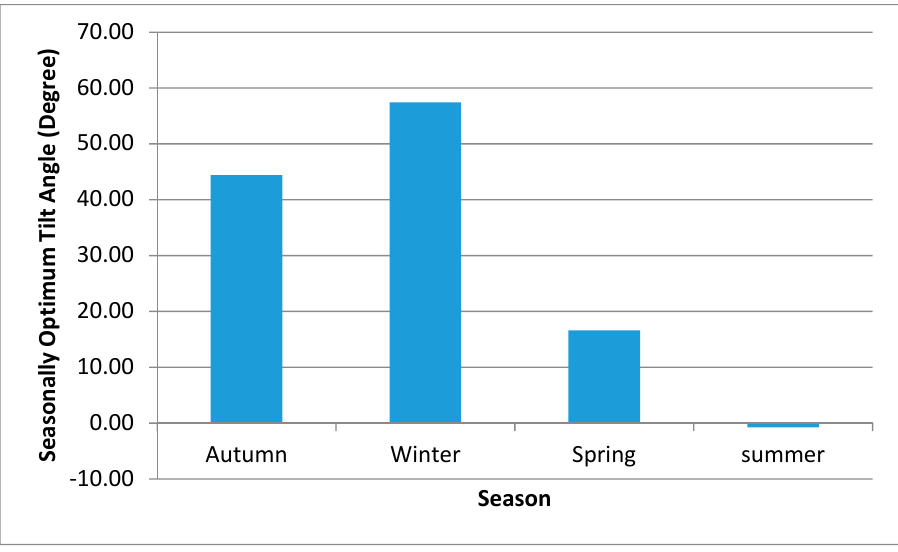
Figure 8. The seasonally optimum tilt angle β opt,s for Jerusalem, Palestine.